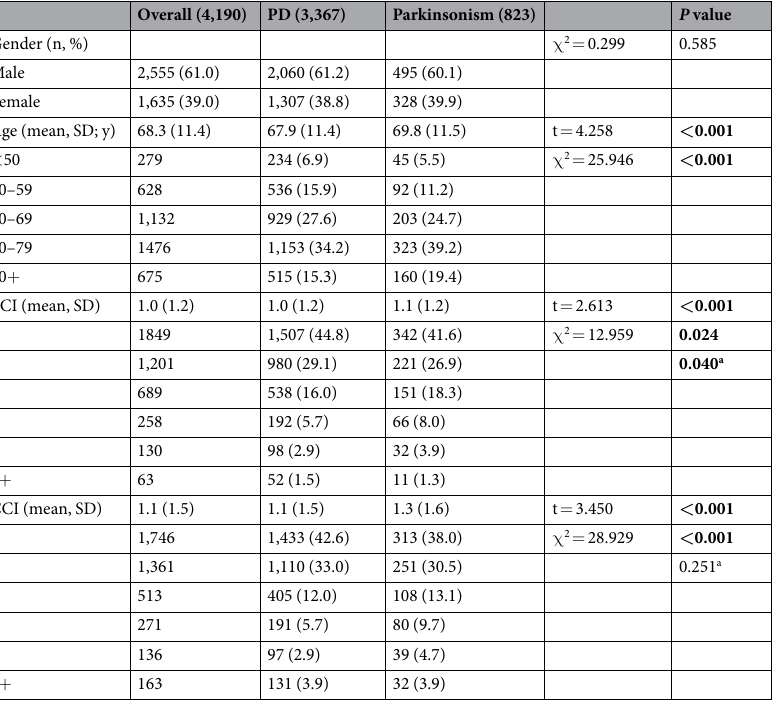
Table 1. Characteristics of study subjects. a P values after adjustment for the influence of age on the comorbidity burden with the general linear